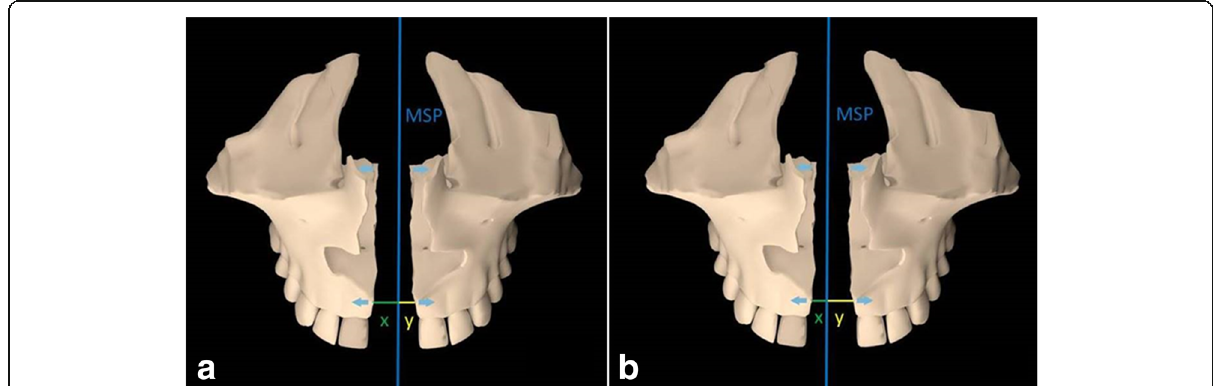
Fig. 11 Schematic representation of transverse asymmetry of split of the midpalatal suture. a Example where the lateral movement of right maxilla (x) is larger than that of left maxilla (y). b Example where the lateral movement of left maxilla (y) is larger than that of right maxilla (x). Blue line,